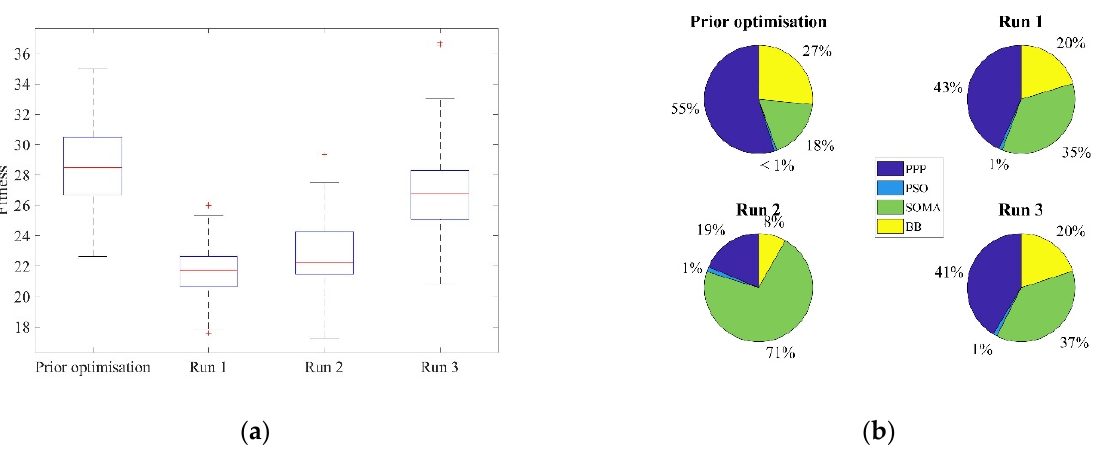
Figure 29. Results from the performance investigation of the dynamic search strategy selection utilising different membership functions (MFs); ( a ) boxplots of the obtained fitness values; ( b ) time the swarm spent utilising the different search strategies.